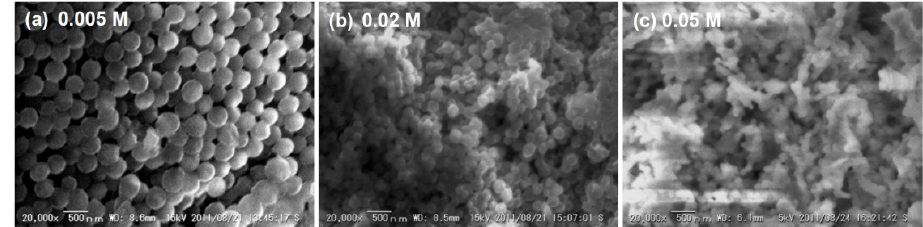
Figure 6. Effect of the monomer concentration on the morphology of polyimide nano-particles [44].